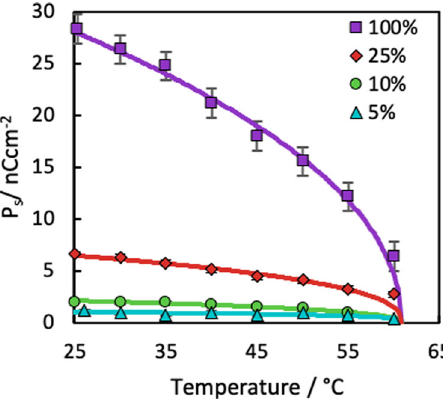
Fig. 7 Spontaneous polarisation measurements of mixtures of SCE13* and SCE13-R. Measurements were taken using the current-reversal technique using a 30 V, 113 Hz triangular waveform on planar-aligned devices. The experimental error bars were calculated from the precision of the area measurement for the current-reversal technique (trapezium rule), together with the uncertainties of measuring mass for the mixtures. The lines are fi ts to Eq. (8). The legend refers to the ratio of SCE13* to SCE13-R; that is, “ 5% ” indicates that the mixture contains 5% SCE13* to 95%